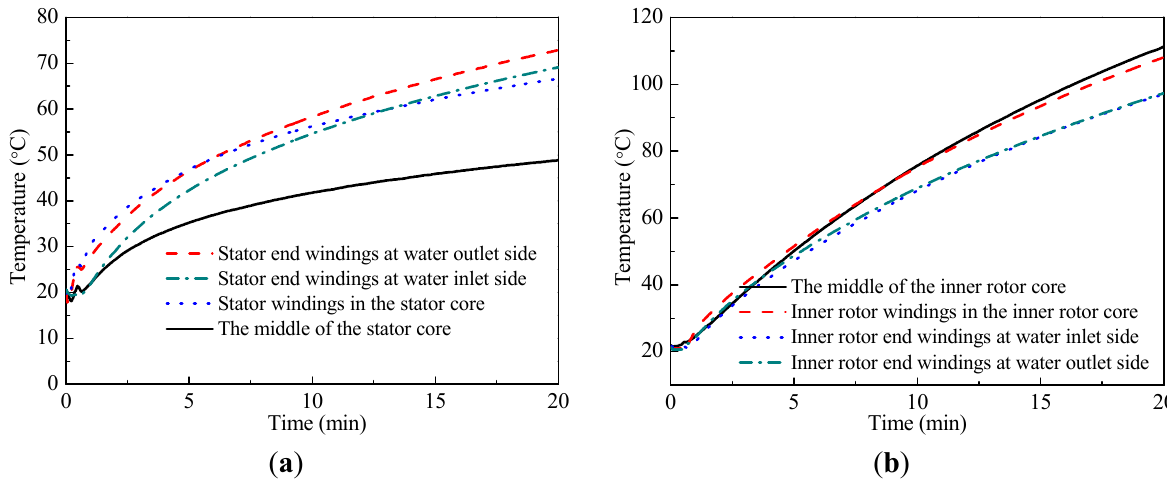
Figure 30. Experimental results when the SM and DRM run at rated torque and rated speed, and only water cooling is used in the casing: ( a ) the SM; and ( b ) the